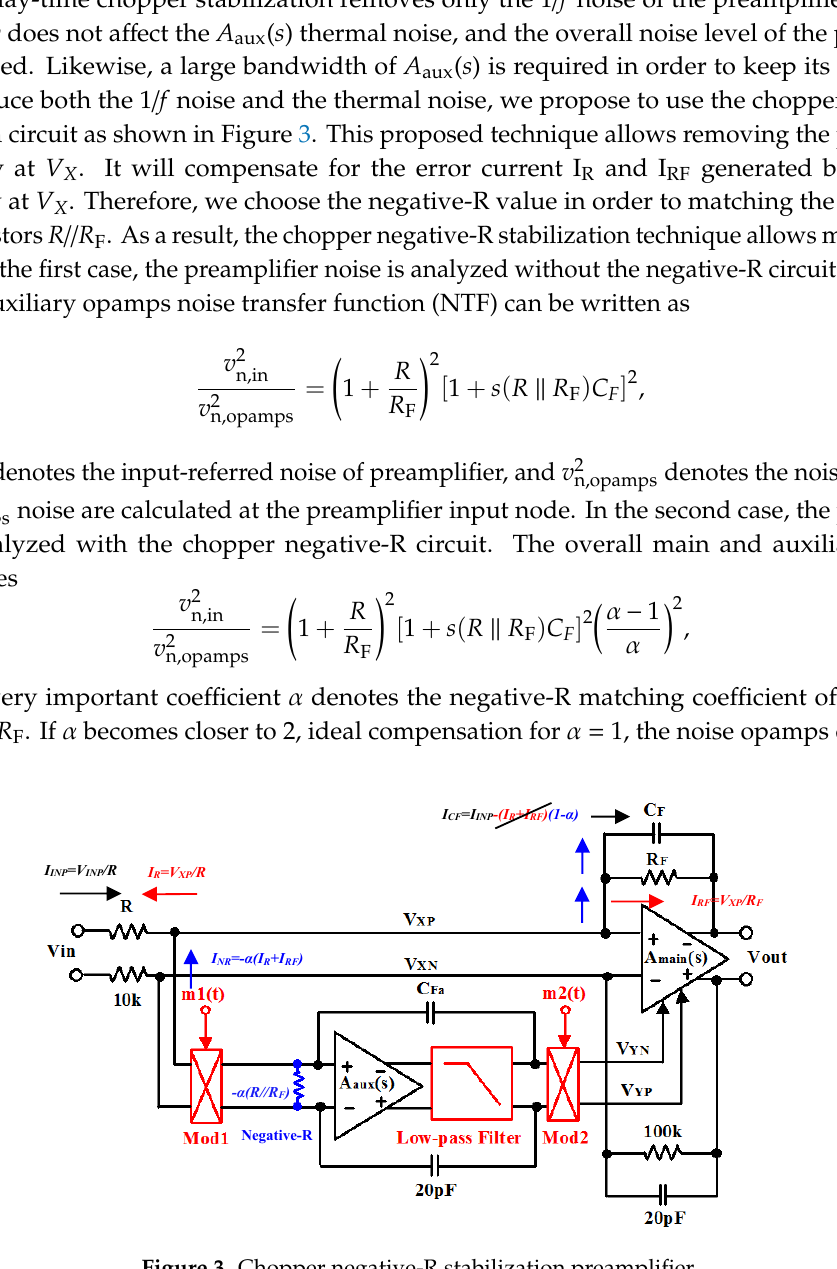
Figure 3. Chopper negative-R stabilization preamplifier.